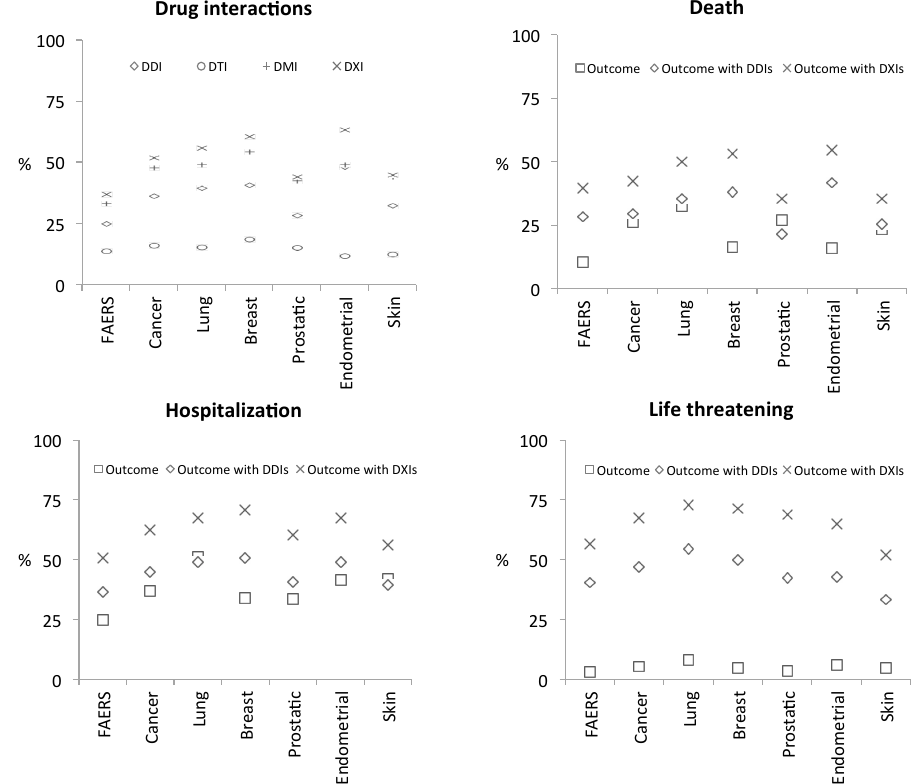
Figure 3. Synopsis of system-level drug-interaction rates and of selected clinical phenotypes detected in FAERS case-reports. Top-left graph (Drug interactions): each FAERS case-report was analyzed for potential drug-interactions (DXIs) as contraindicated in drug-labels (i.e., known/label DDIs) and with respect to interactions that can occur at the level of targets (DTIs) and metabolizing-enzymes (DMIs). Results were then grouped with respect to five cancer-indications (lung, breast, prostate, endometrial, and skin neoplasms). Percentages (%) reflect how frequently interactions occur in the different cohorts based on the number of cases that a certain drug-interaction type (namely, DDIs, DTIs, DMIs, or any of those, i.e., DXIs) was detected in that context. Remaining graphs (Outcomes ‘Death’, ‘Hospitalization’, and ‘Life threatening’): to assess the effect of co-medications on clinical response we asked what proportion (%) of each phenotype’s cases, per cohort, occur in patients with DDIs (rhombus symbol) and DXIs (x symbol)—we observe that DXI prevalence among each phenotype remains high irrespective of the disease-indication (x-axis), or the actual rate of that phenotype within each cohort (square symbols; proportion of phenotype within patient-cases of each cohort).